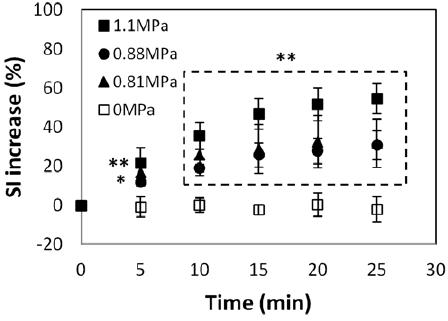
Figure 3. The average normalized signal intensity (SI) change measured in a time-series of contrast enhanced T1-weighted images for all animals (mean ± S.D.). The horizontal axis shows the interval after Gd-DTPA injection, which was administered 10 min after the last sonication in each eye. The measurements were obtained in a region of interest that included the sonicated portion of the retina and the vitreous humor. The pressure amplitudes of these sonications were: 0.81 (N=6), 0.88 (N=4), 1.1 MPa (N=6) for sonicated eyes and 0 MPa (n=4) for the control eyes. The SI increase in the sonicated eyes was significantly larger than that in the controls at every time point (* p , 0.05; ** p , 0.01).